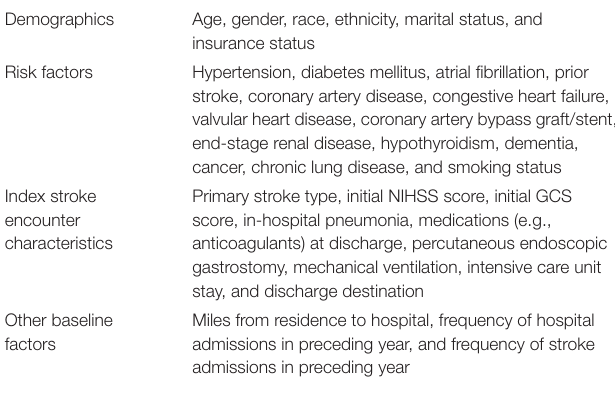
TABLE 1 | List of discrete features extracted from enterprise data